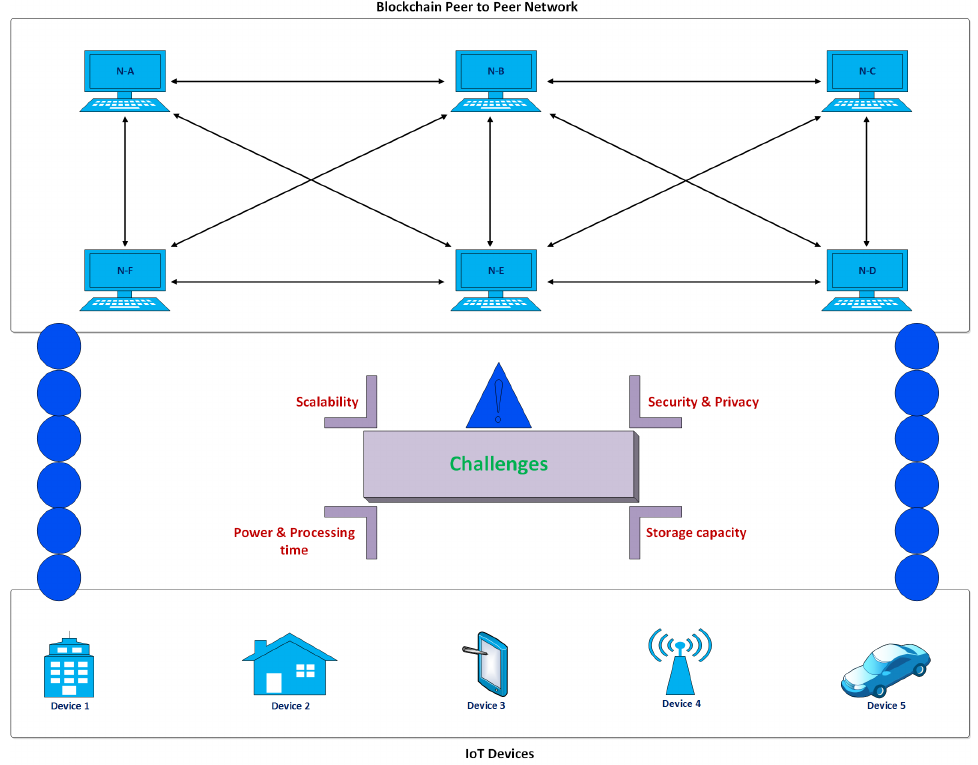
Figure 1. Blockchain IoT